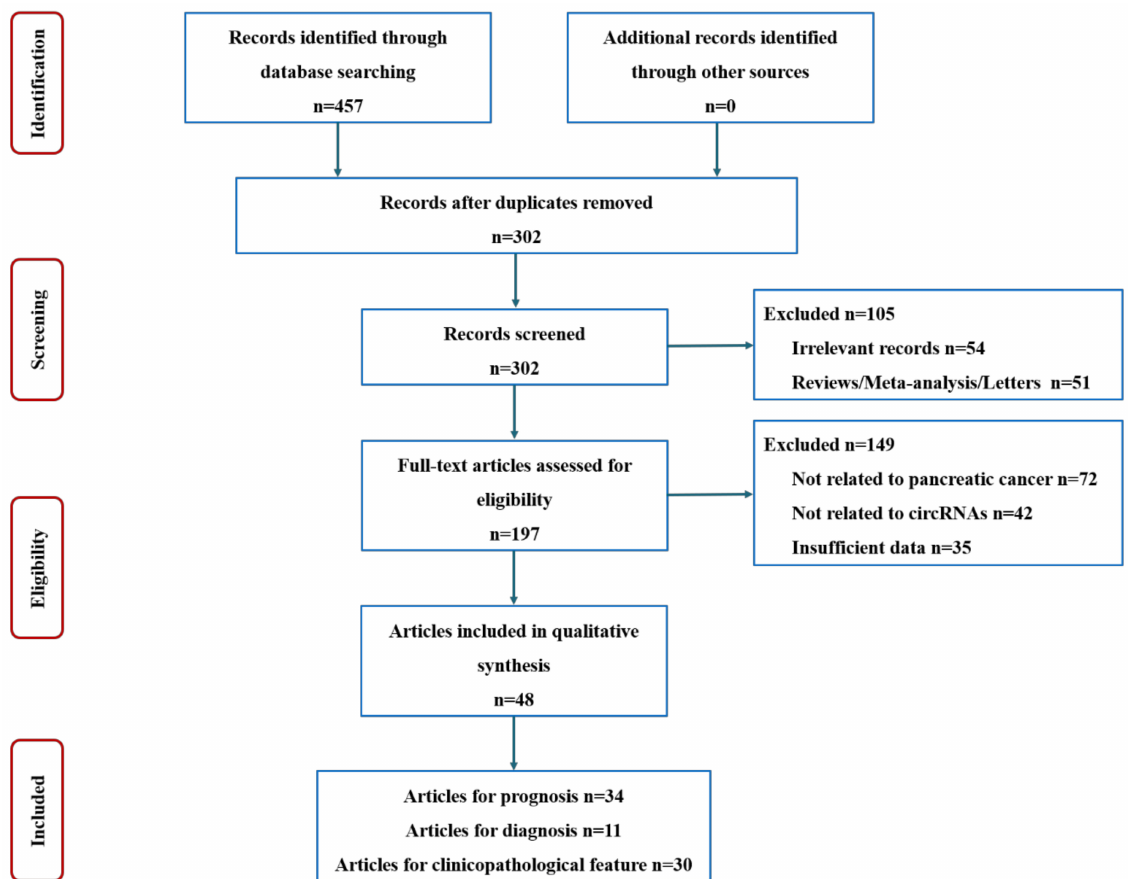
Figure 1. Flow diagram of the study selection